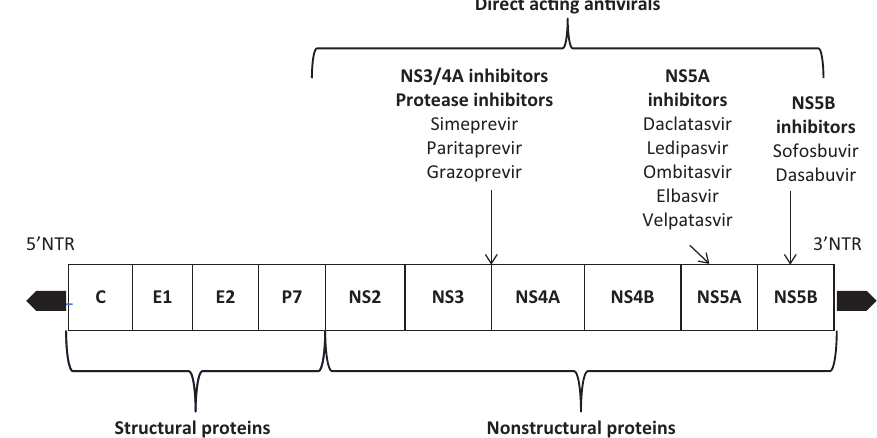
Figure 2. The hepatitis C virus genome and target sites of action of the direct-acting antiviral agents (6). Table 3. The four classes of direct-acting antiviral agents The four classes of